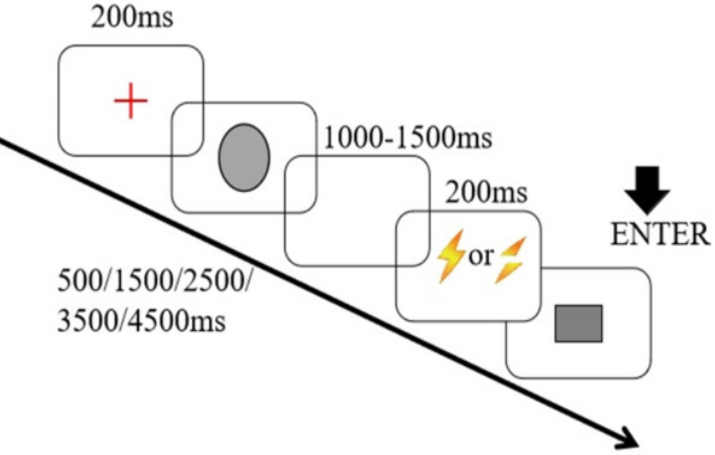
Figure 1. A depiction of the exercise phase and formal experiment in the duration-reproduction task.